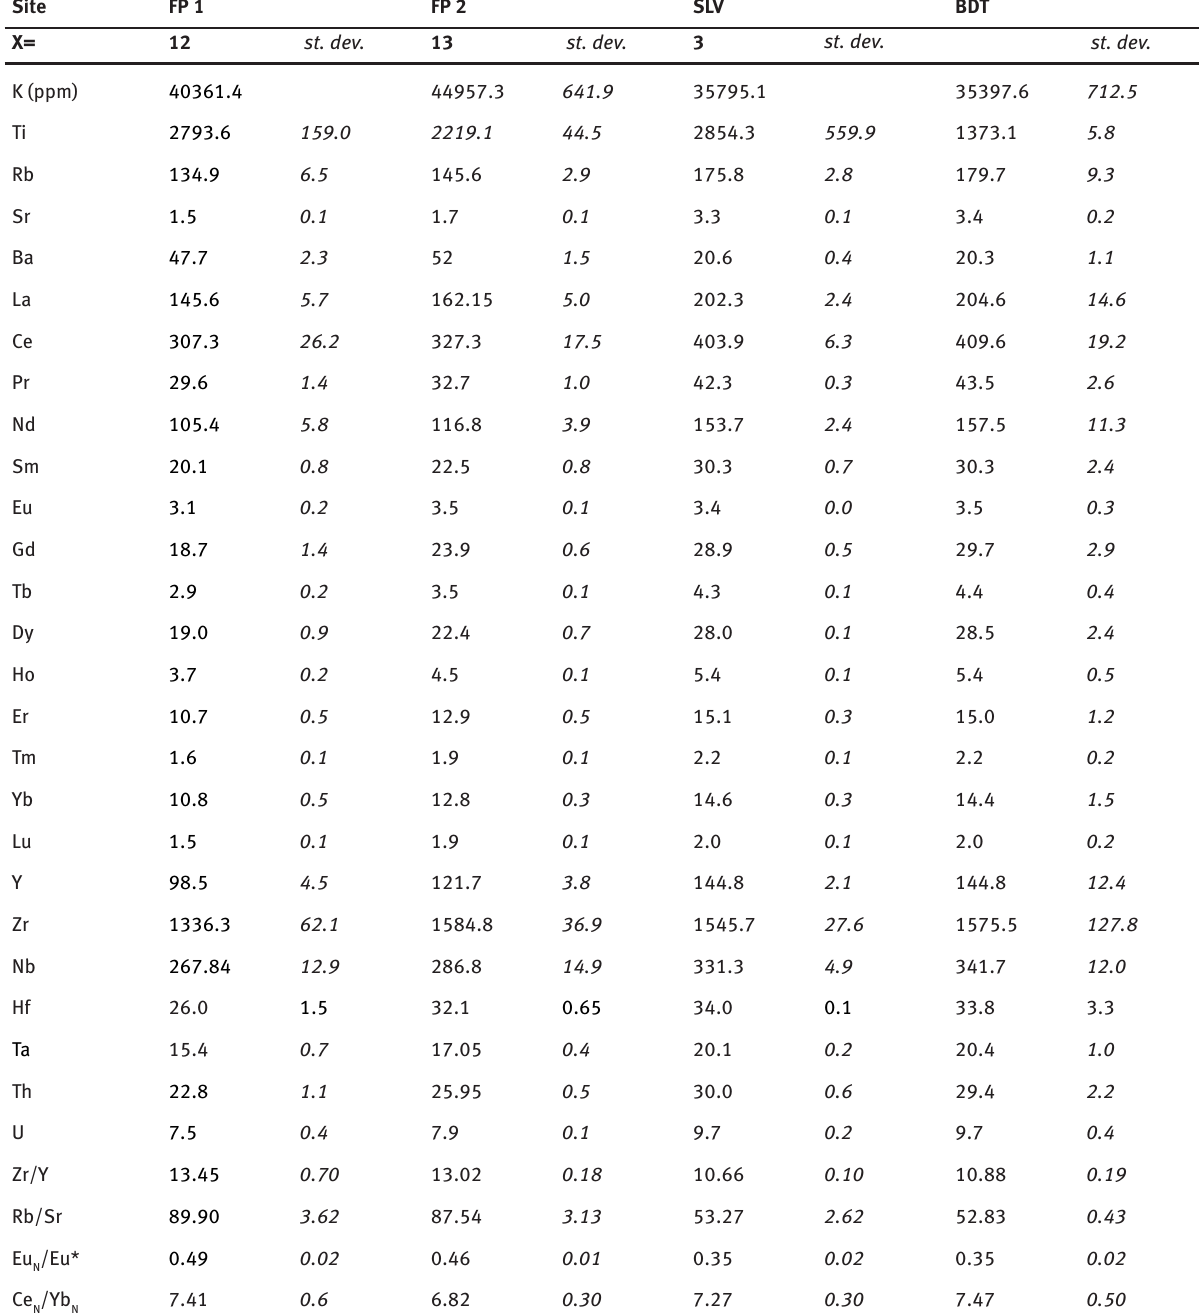
Table 3: Mean and std. deviation (2-sigma) of trace element analyses of obsidians obtained by LA-ICP-MS. X = n° of analyses for the calcu- lation of the mean. The subscript stands for ‘normalised’ (concentration of the given element in the sample divided by the correspondent N concentration in the reference chondrite, chondrite values from McDonough and Sun (1995). Eu anomaly, see text. Site abbreviations as in Table